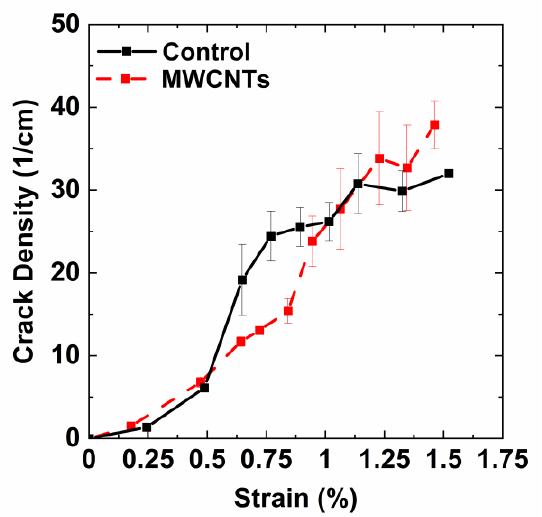
Figure 12. Measured crack density from edge replicas with increasing strain under cyclic loading for the control and MWCNT specimens.